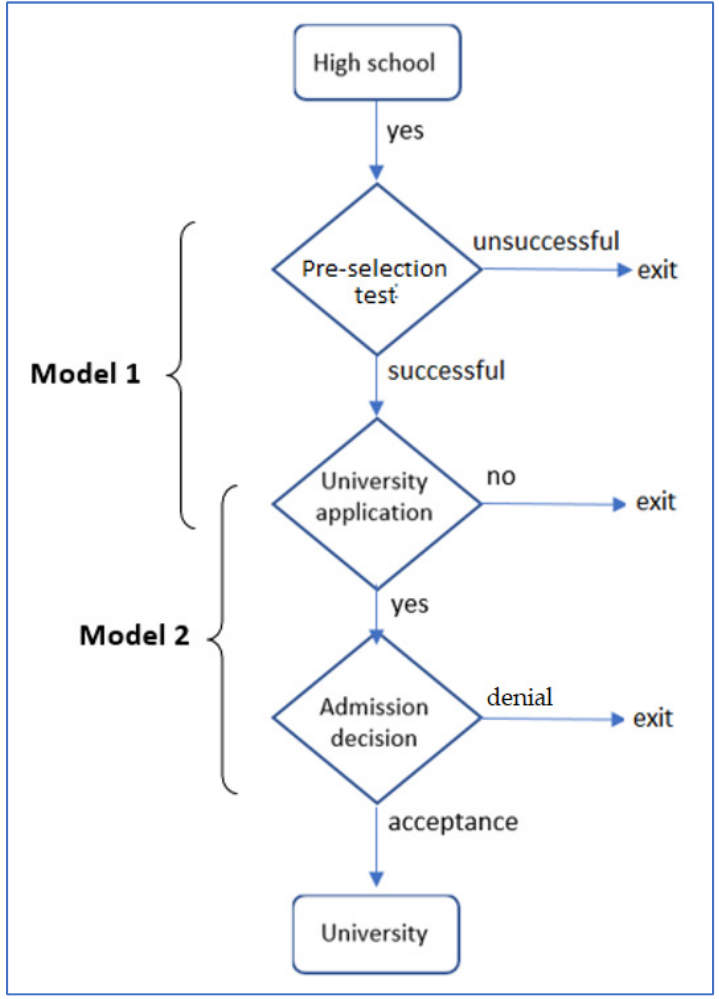
Figure 3. Flowchart of the trajectory toward higher education.